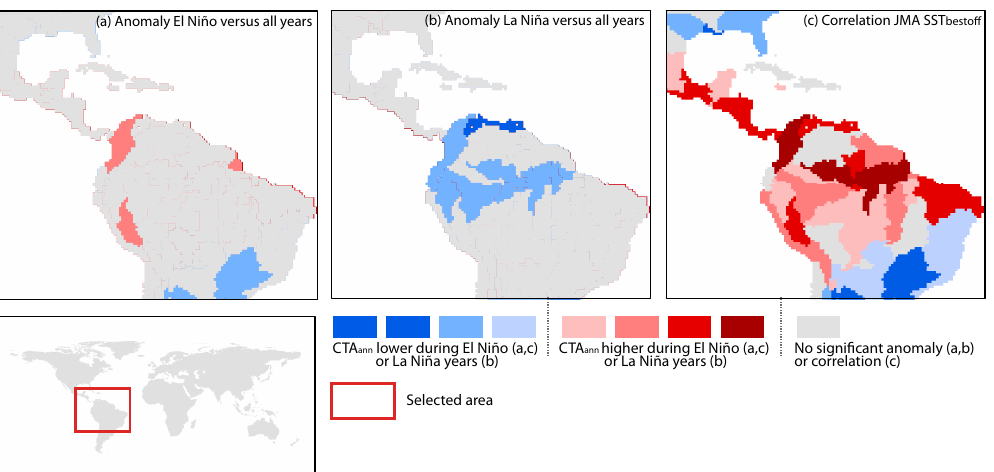
Figure 3. Comparison of results found when studying the (a) anomaly in water scarcity conditions (CTA ratio) between El Niño and all years, (b) anomaly in water scarcity conditions (CTA ratio) between La Niña and all years, and (c) the sensitivity of water scarcity conditions (CTA ratio) to ENSO-driven climate variability measured by means of the JMA SST bestoff . Red colours indicate more severe scarcity conditions under El Niño phases (a, c) or La Niña phases (b) . Blue colours indicate less severe scarcity conditions under El Niño phases (a, c) or La Niña phases (b) .